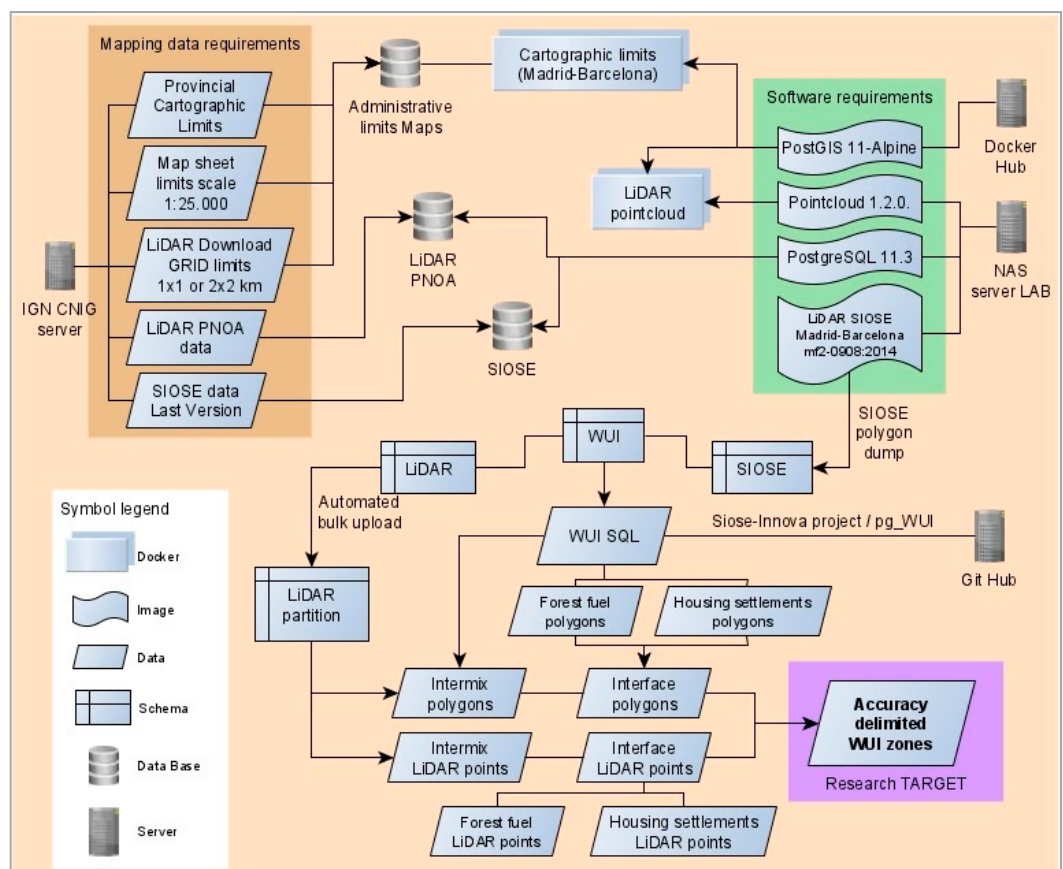
Figure 3. Theoretical procedure to calculate accuracy of delimited WUI zones